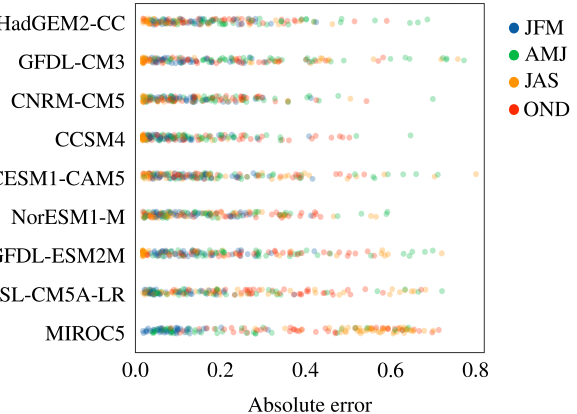
Figure 19. The absolute errors of SICs between CMIP5 and ERA5 from January 2006 to September 2020 in sub-region No.